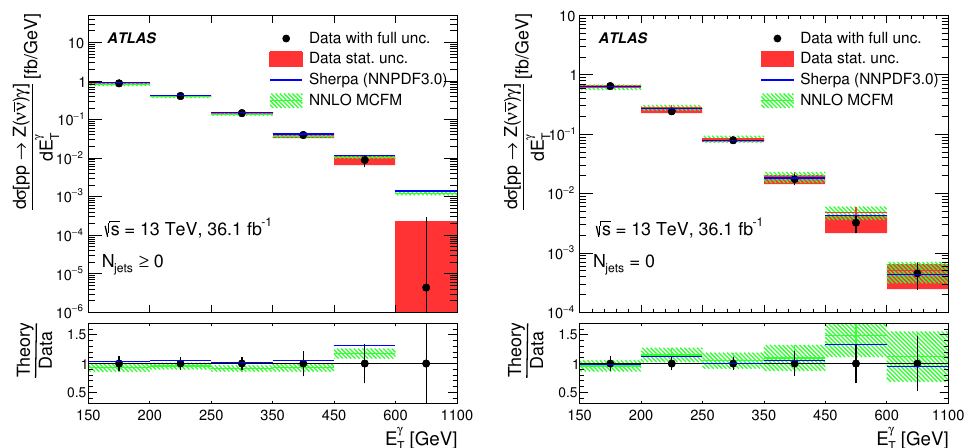
Figure 4 . The measured (points with error bars) and predicted di(cid:11)erential cross sections as a function of E (cid:13) for the pp Z ( (cid:23) (cid:22) (cid:23) ) (cid:13) process in the inclusive N jets 0 (left) and exclusive N jets = 0 T ! (cid:21) (right) extended (cid:12)ducial regions. The error bars on the data points show the sum in quadrature of the statistical and systematic uncertainties. The Mcfm NNLO predictions are shown with shaded bands that indicate the theoretical uncertainties described in section 5.4. For the Sherpa predictions, systematic uncertainty is not considered, and the statistical uncertainties arising from the size of the MC samples are too small to be visible. The lower plots show the ratios of the SM expectation to the measured values (shaded bands), with the error bars on the points showing the relative uncertainties in the experimental measurements. The bin size varies from 50 GeV to 500